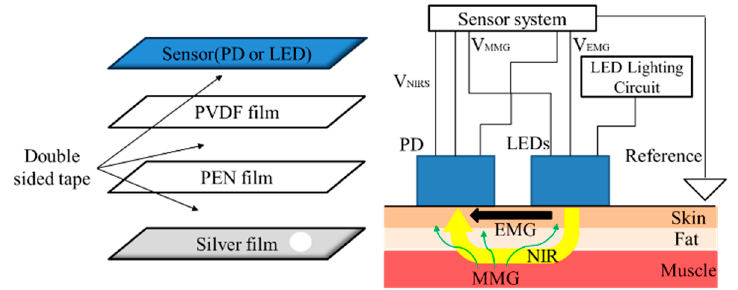
Figure 2. Schematic diagram of the measurement system for EMG, MMG and NIRS and changes in concentrations of oxyhemoglobin (HbO 2 ) and deoxyhemoglobin (Hb) are obtained through NIRS using LED and PD, respectively. EMG, MMG and NIRS are thus measured simultaneously by a pair of sensors.